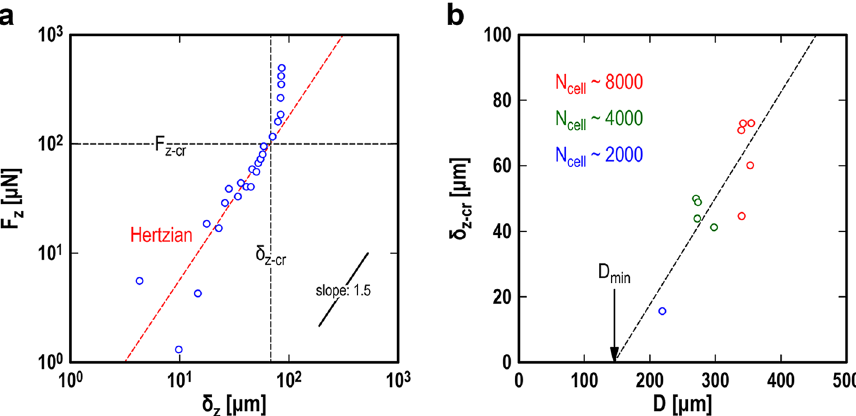
Figure 2. The static properties of single cardiac spheroids (CSs). ( a ) The normal load, F z = k z z 2 , is plotted against the indentation depth, δ z = ( z 1 – z 2 )/2, for the local minimum values of z 2 ( t ) (i.e., the blue circles in Fig. 1d). The red broken line is a fitting function with a slope of 1.5 based on Hertzian contact theory for the contact between a sphere and a plane, used to evaluate the elasticity of the tested CS (e.g., its effective elastic modulus is E = 5.2 kPa). ( b ) The critical indentation depth δ z -cr at which the CS was collapsed by compressive loading is plotted against the CS diameter, D , and is used to evaluate the toughness of the tested CSs. The black broken line is a linear fitting function intersecting the horizontal axis at D = D min = 146 μm. The plotted data in ( b ) are for ten different CSs, the diameters of which are ranged from 219 to 355